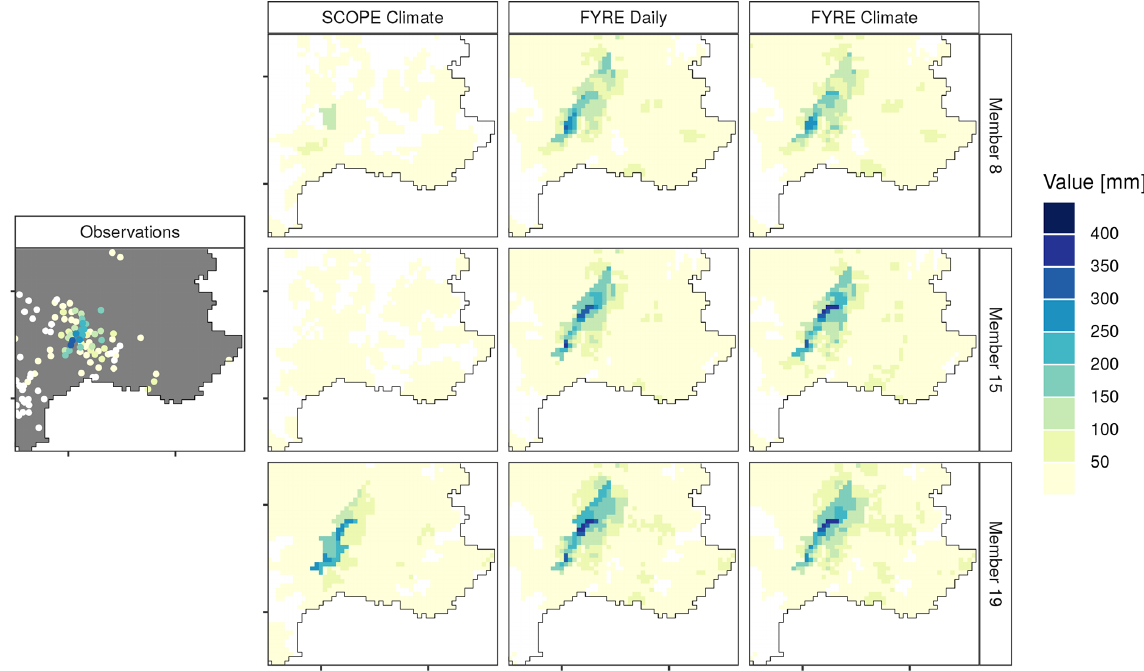
Figure 12. 21 September 1890 precipitation over southeast France from observations (left panel) and from three randomly selected members of SCOPE Climate/FYRE Daily/FYRE Climate (right